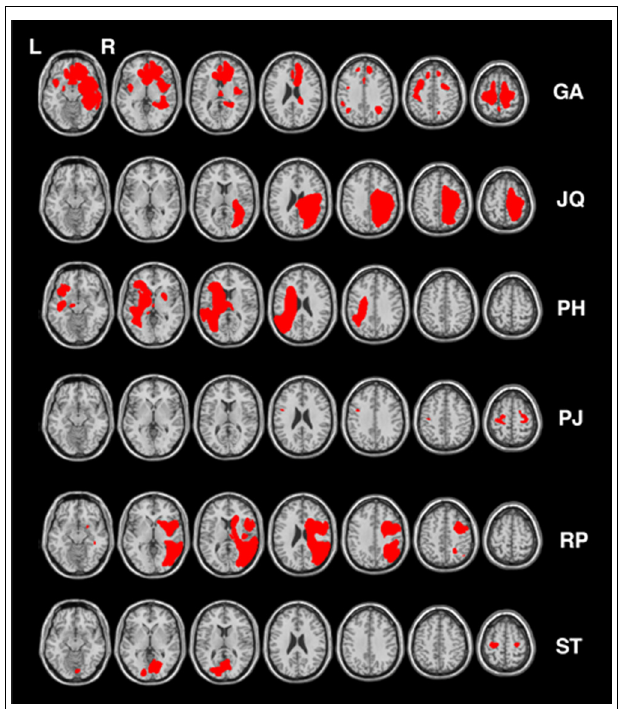
FIGURE 2 | Lesion reconstruction for all control patients. Each patient’s lesion map was reconstructed based on outlier detection method combined with fuzzy clustering algorithm (see Seghier etal., 2008; Chechlacz etal., 2012). All lesion maps are presented as an overlay on a